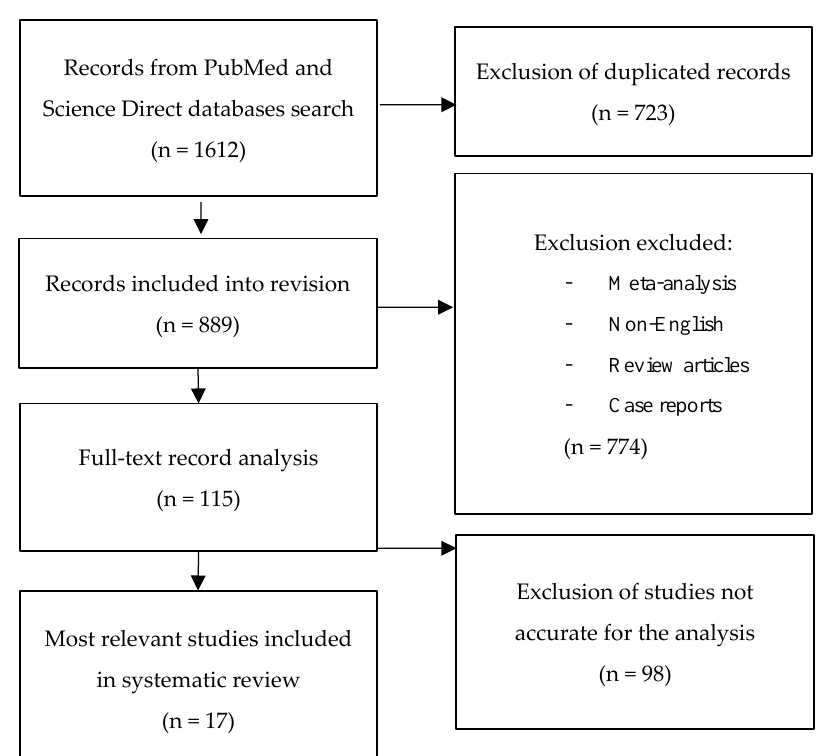
Figure 1. A graphical diagram of the selection of the literature data for the review. Table 1. The inflammasome in psoriasis.